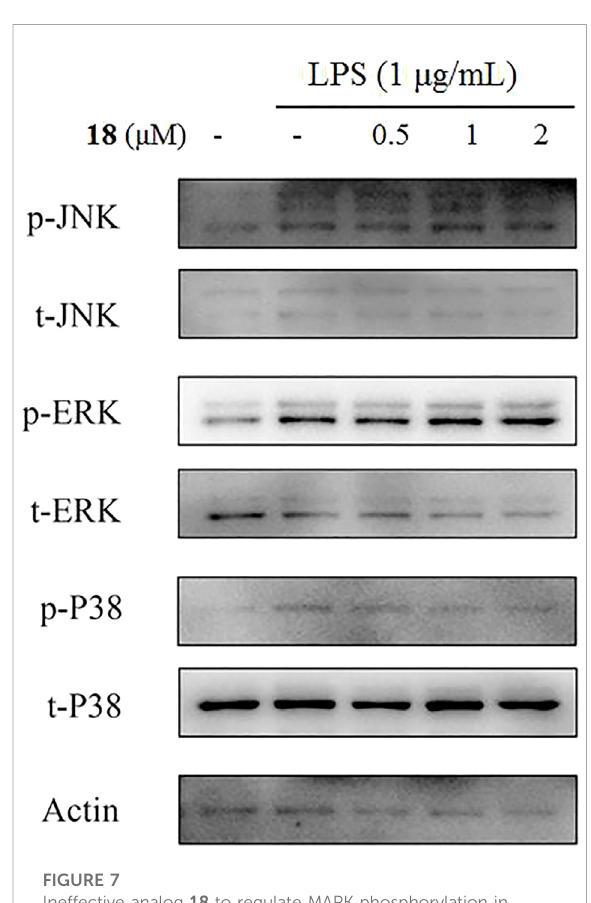
FIGURE 7 Ineffective analog 18 to regulate MAPK phosphorylation in LPS-stimulated BV-2